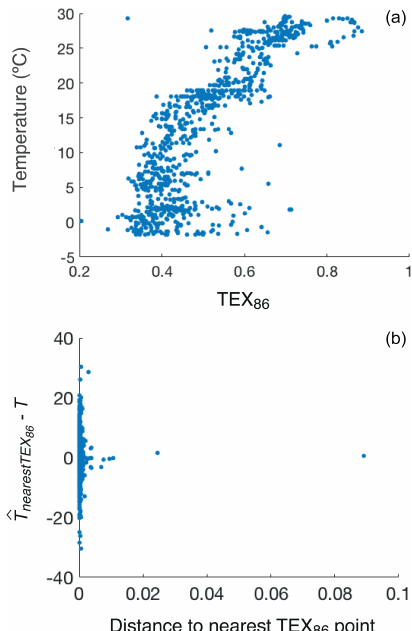
Figure 3. (a) The temperature of the modern dataset as a function of the TEX 86 value, showing a clear linear correlation between the two, but also significant scatter. (b) The error of the predictor based on the nearest TEX 86 calibration